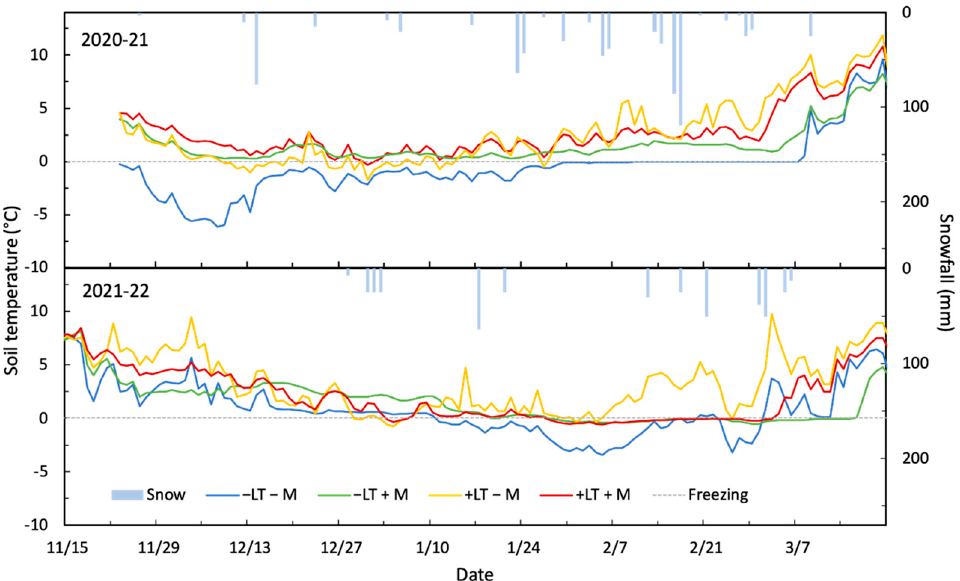
Figure 1. Average daily snowfall (light blue bars) and soil temperature (0.05 m depth) during the winter of 2020-21 (top) and 2021-22 (bottom) under no cover ( − LT − M; blue line), mulch ( − LT + M; green line), a fabric low tunnel (+LT − M; yellow line), and mulch and a fabric low tunnel (+LT + M; red line) in the field in North Logan, UT.